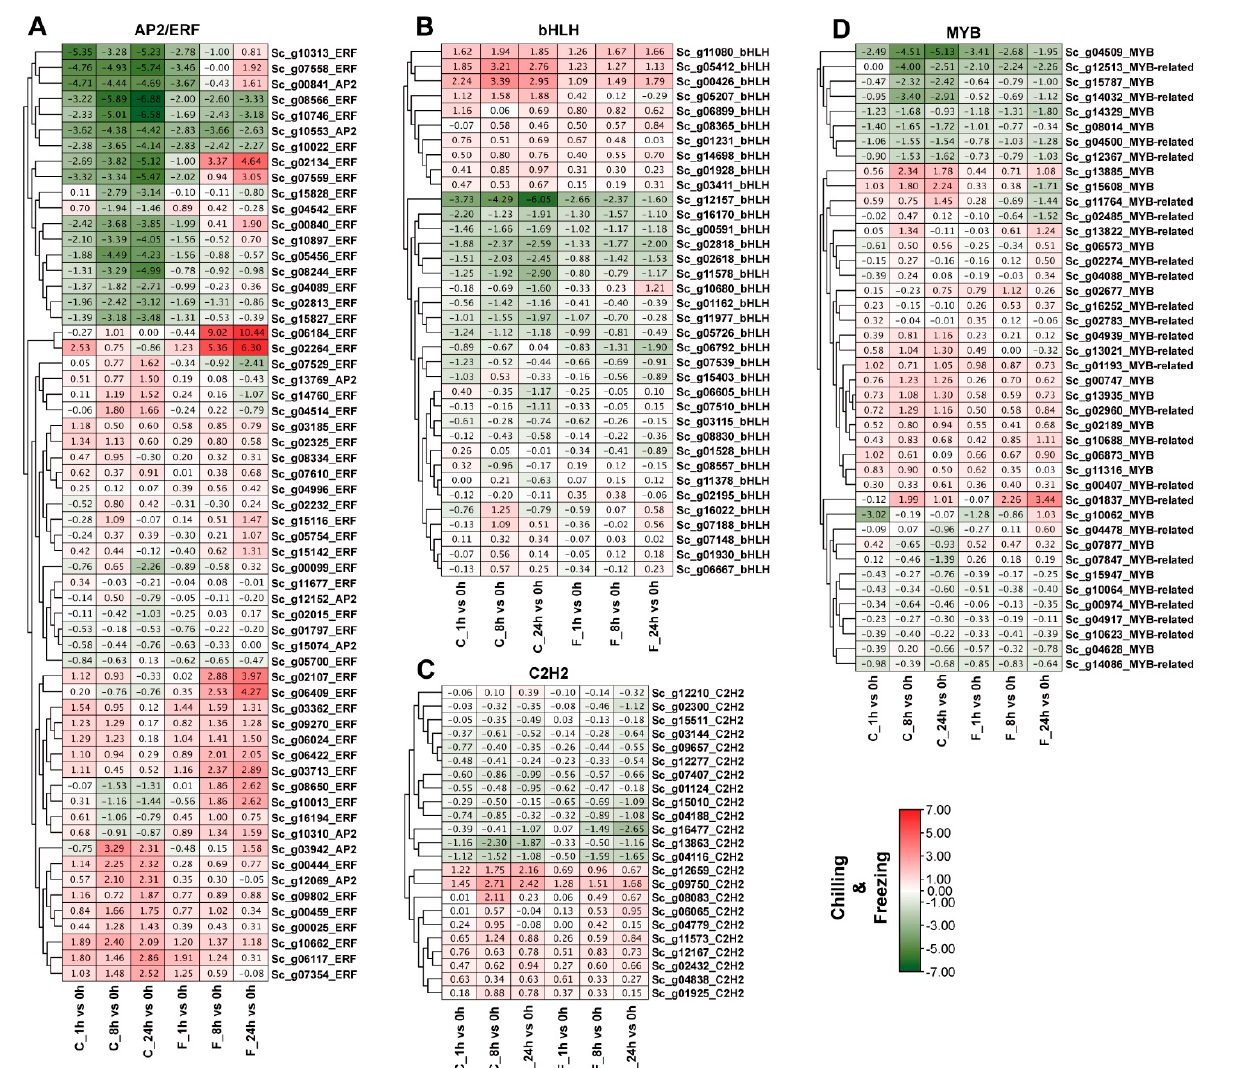
Figure 7. Expression analysis of the top four TF family genes was examined using hierarchical clustering in different time-series of chilling and freezing stresses. FPKM values of representative transcript levels of TF members. The standardized expression data was used to generate a heatmap with hierarchical clustering based on the Manhattan correlation with average linkage using the MeV software package. Expression levels of ( A ) AP2/ERF, ( B ) bHLH, ( C ) MYB, ( D ) C2H2-zinc finger genes under chilling and freezing stresses at 1, 8, and 24 h. The heatmap shows the change in the average log2 (fold-change) of each transcript.